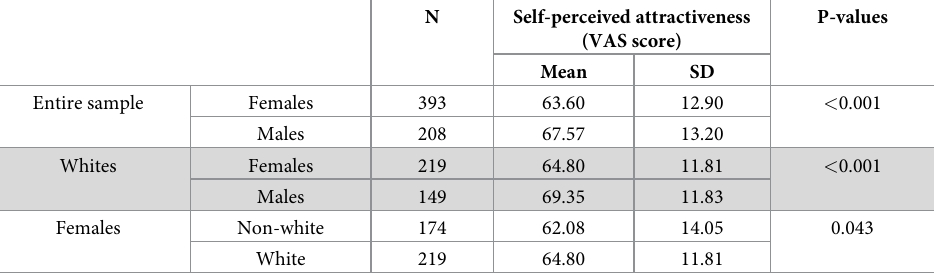
Table 1. Comparisons (independent t-tests) of self-perceived facial attractiveness scores within the entire sample and within